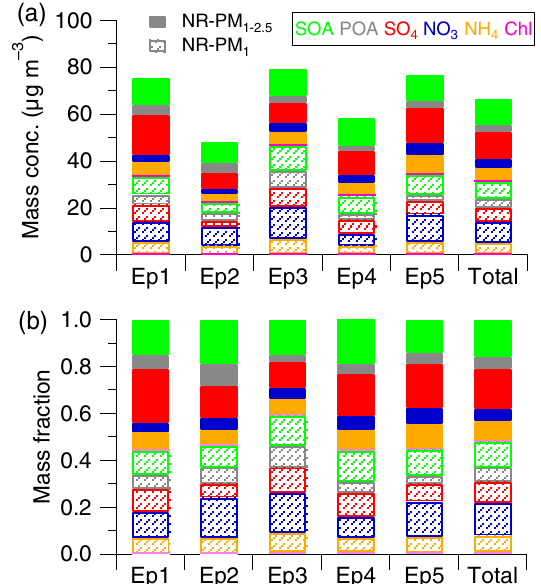
Figure 6. Mass concentration (a) and fraction (b) of the NR-PM 1 and NR-PM 1 − 2 . 5 chemical components in NR-PM 2 . 5 , respectively, during the different episodes (Ep1–Ep5) marked in Fig. 5 and the entire study period